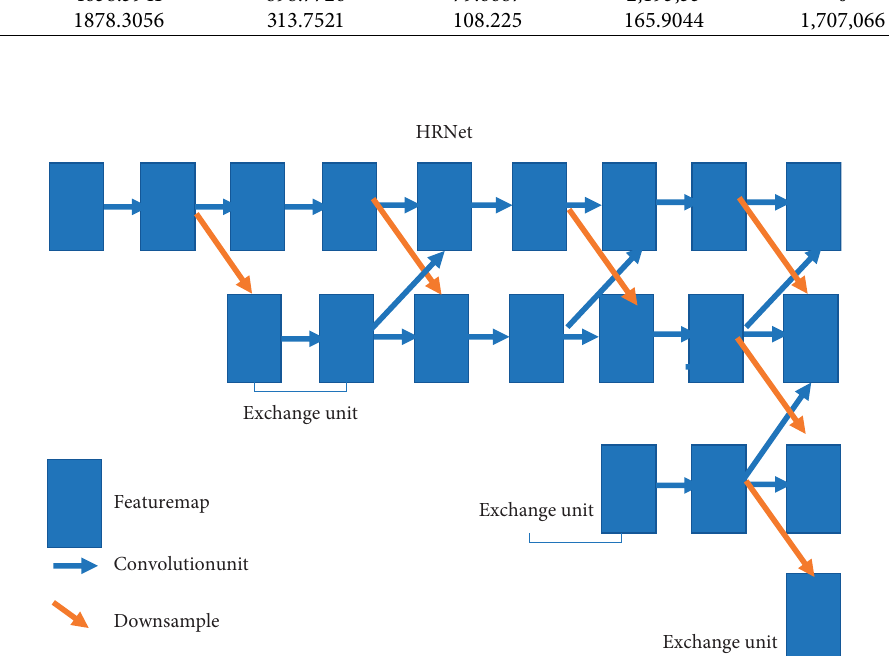
Figure 2: HRNet backbone